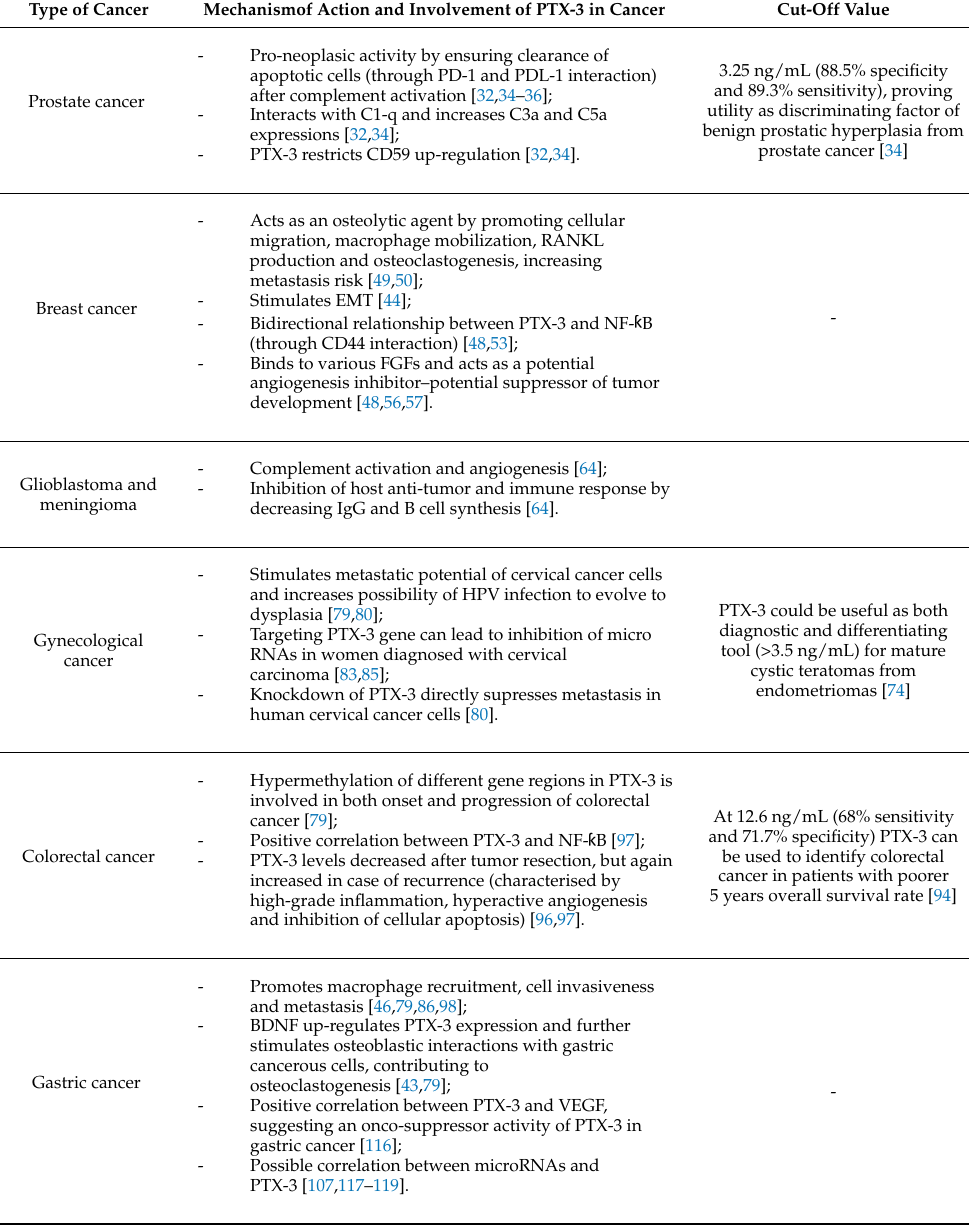
Table 1. PTX-3—mechanisms of action and involvement in various types of